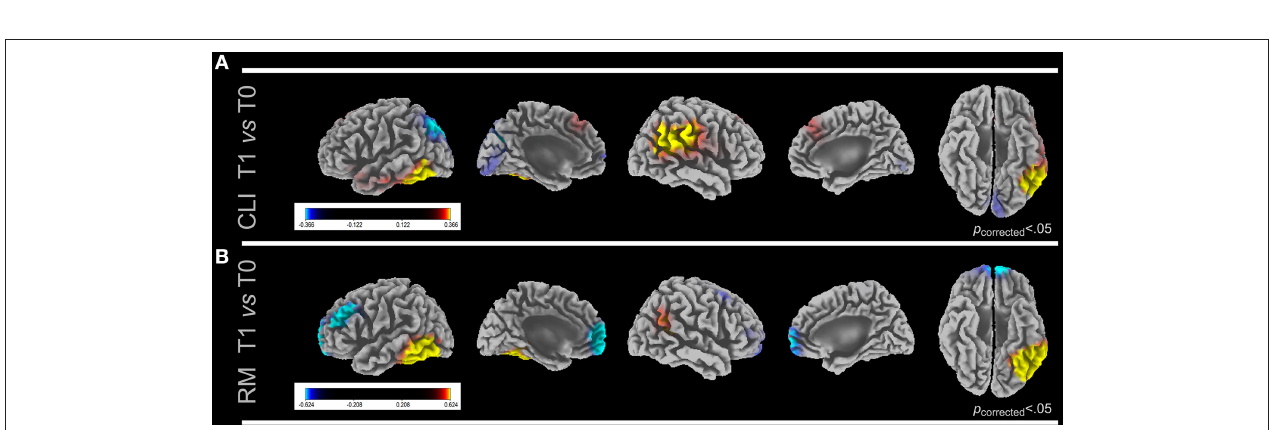
FIGURE 1 | LORETA images show cortical activation differences in gamma band at first session (T0) between CLI vs. CTR (A), RM vs. CTR (B), and RM vs. SGP, (C). Five views of the brain (lateral and medial left hemisphere, lateral and medial right hemisphere and ventral view) are shown for each comparison. Significant F -values (Bonferroni corrected) are reported. F -values colored scale is also shown for each comparison. Yellow, first group > second group; blue, second group > first group. CLI, All Clients; RM, Rome Clients; SGP, San Giuliano di Puglia Clients.